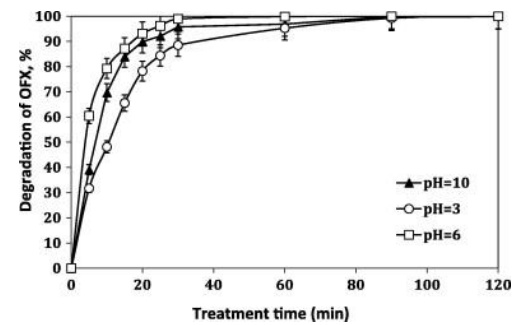
Figure 5. E ff ect of the pH solution on the degradation of Ofloxacin (OFX). Experimental conditions: [OFX] 0 = 10 mg / L; [TiO 2 ] = 1 g / L; 640 W / L. Reprinted with permission from [67], copyright 2013, Elsevier.